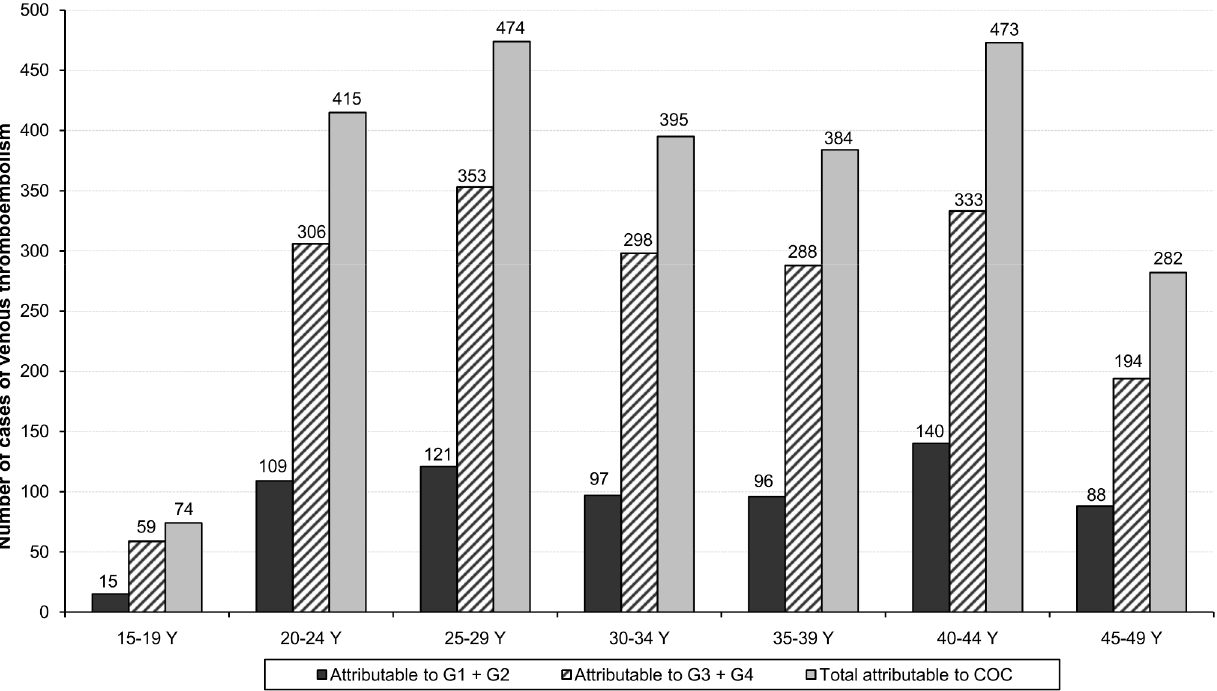
Figure 3. Number of cases of venous thromboembolism attributable to combined oral contraceptives in 2011. The figure shows the number of cases attributable to combined oral contraceptives broken into age group, overall and by generation.